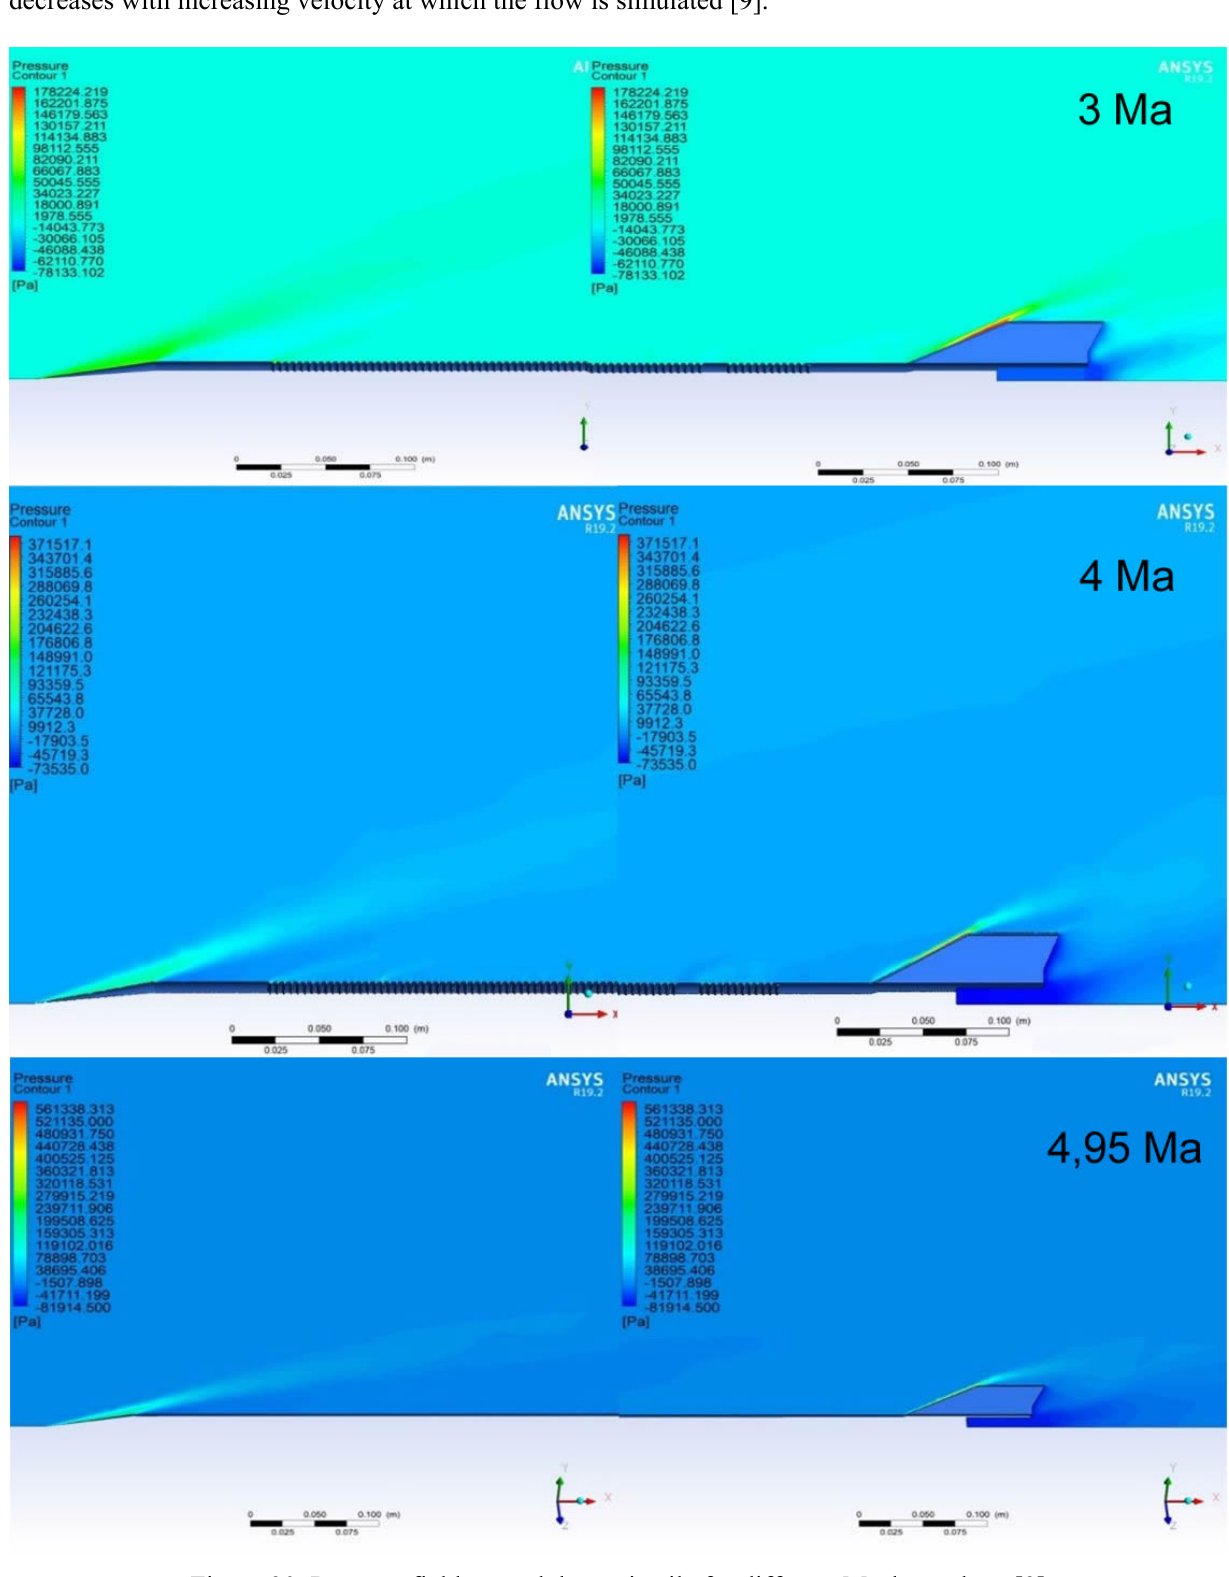
Figure 30. Pressure field around the projectile for different Mach numbers